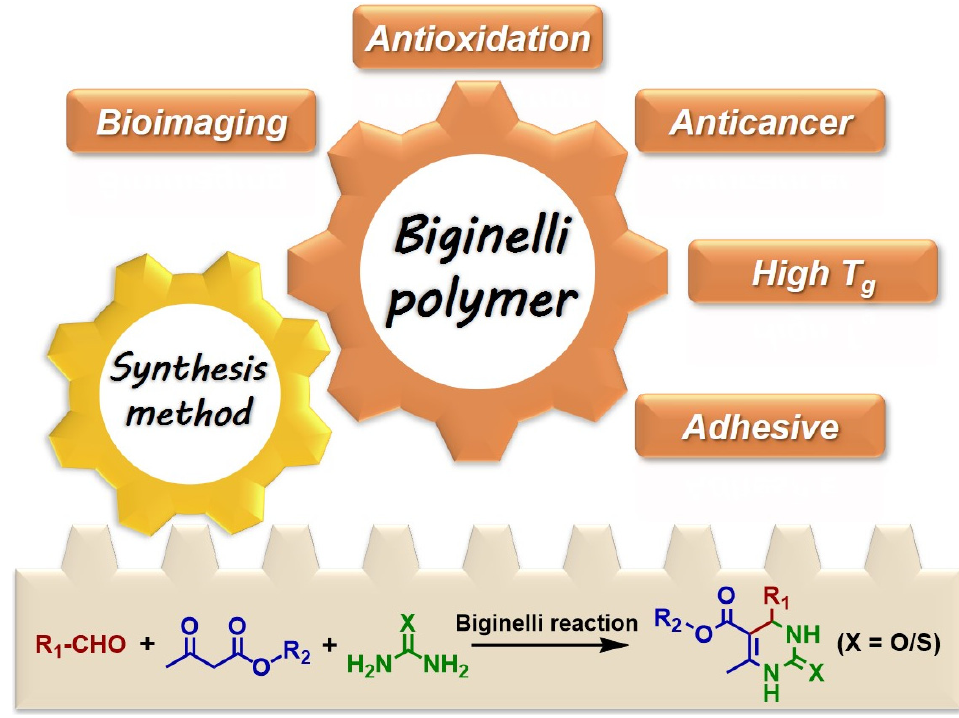
Figure 1. The Biginelli reaction in polymer chemistry.